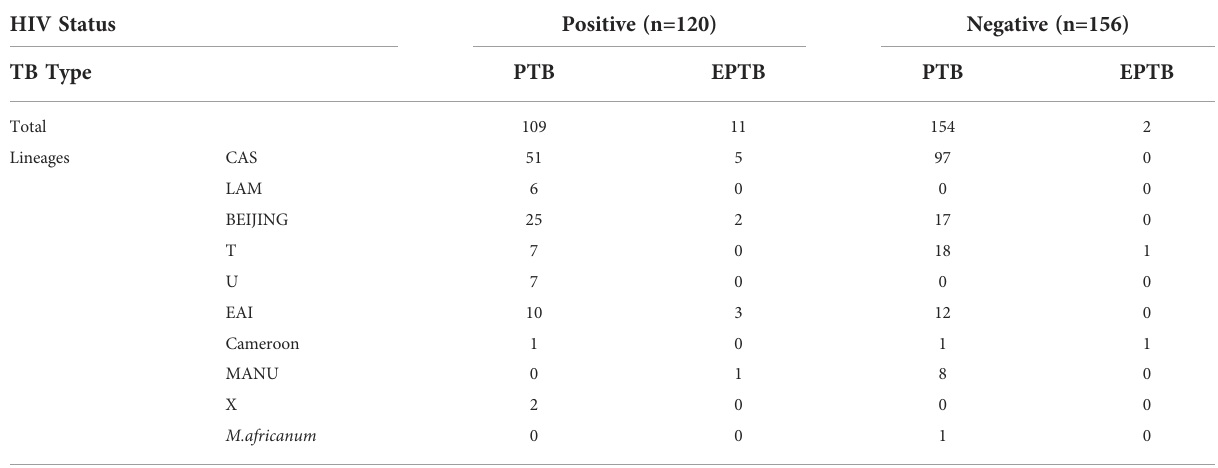
TABLE 2 Lineage distribution in pulmonary and extrapulmonary